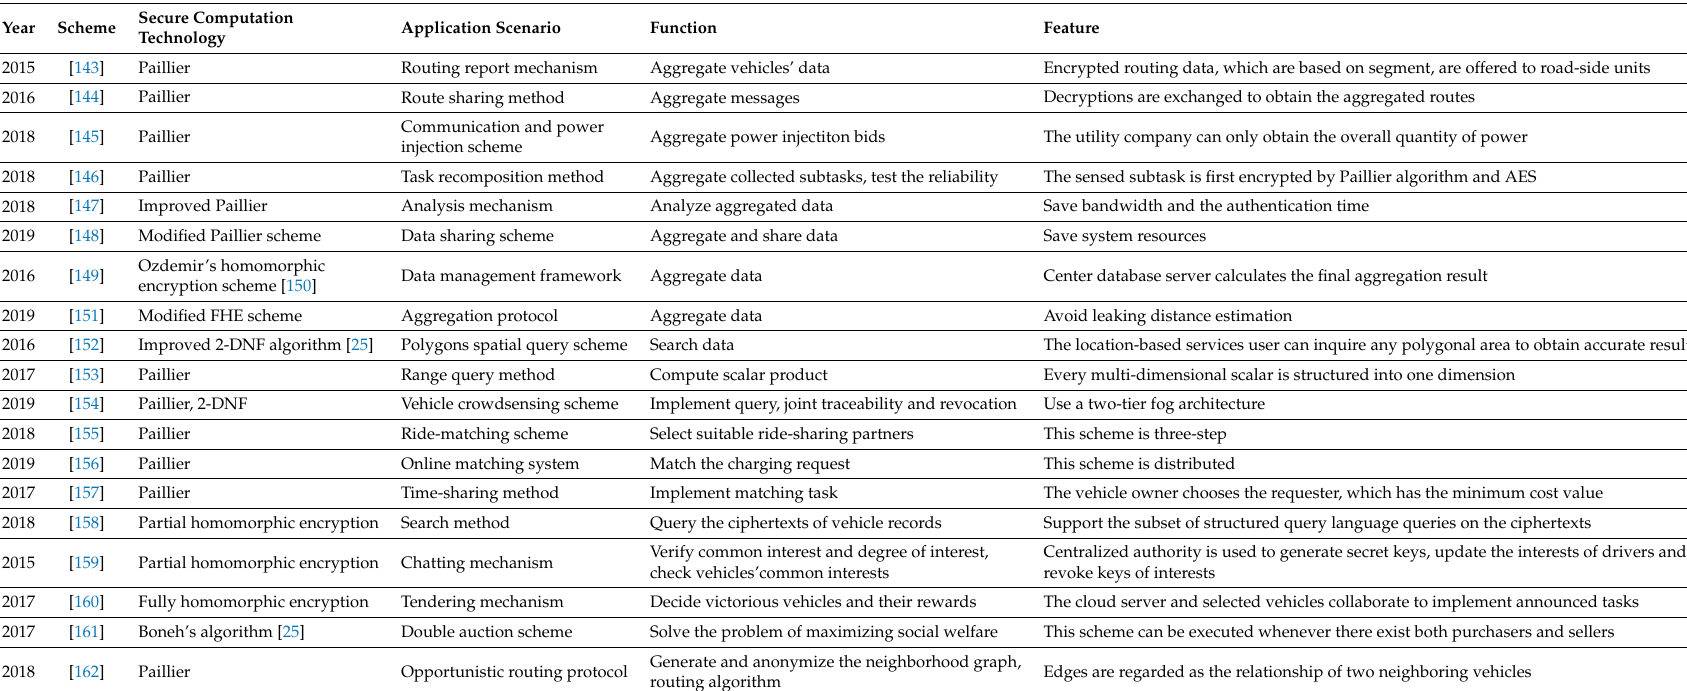
Table 1. The comparison of homomorphic encryption-based secure computation in vehicular ad hoc